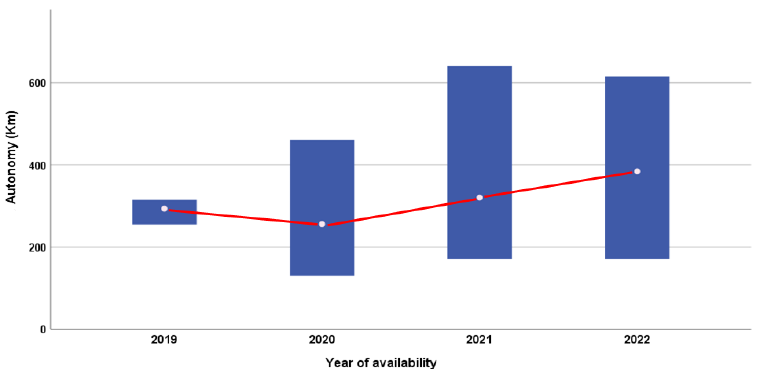
Figure 5. Range bar variation (min, max, mean) representation of autonomy vs. year of availability in market.